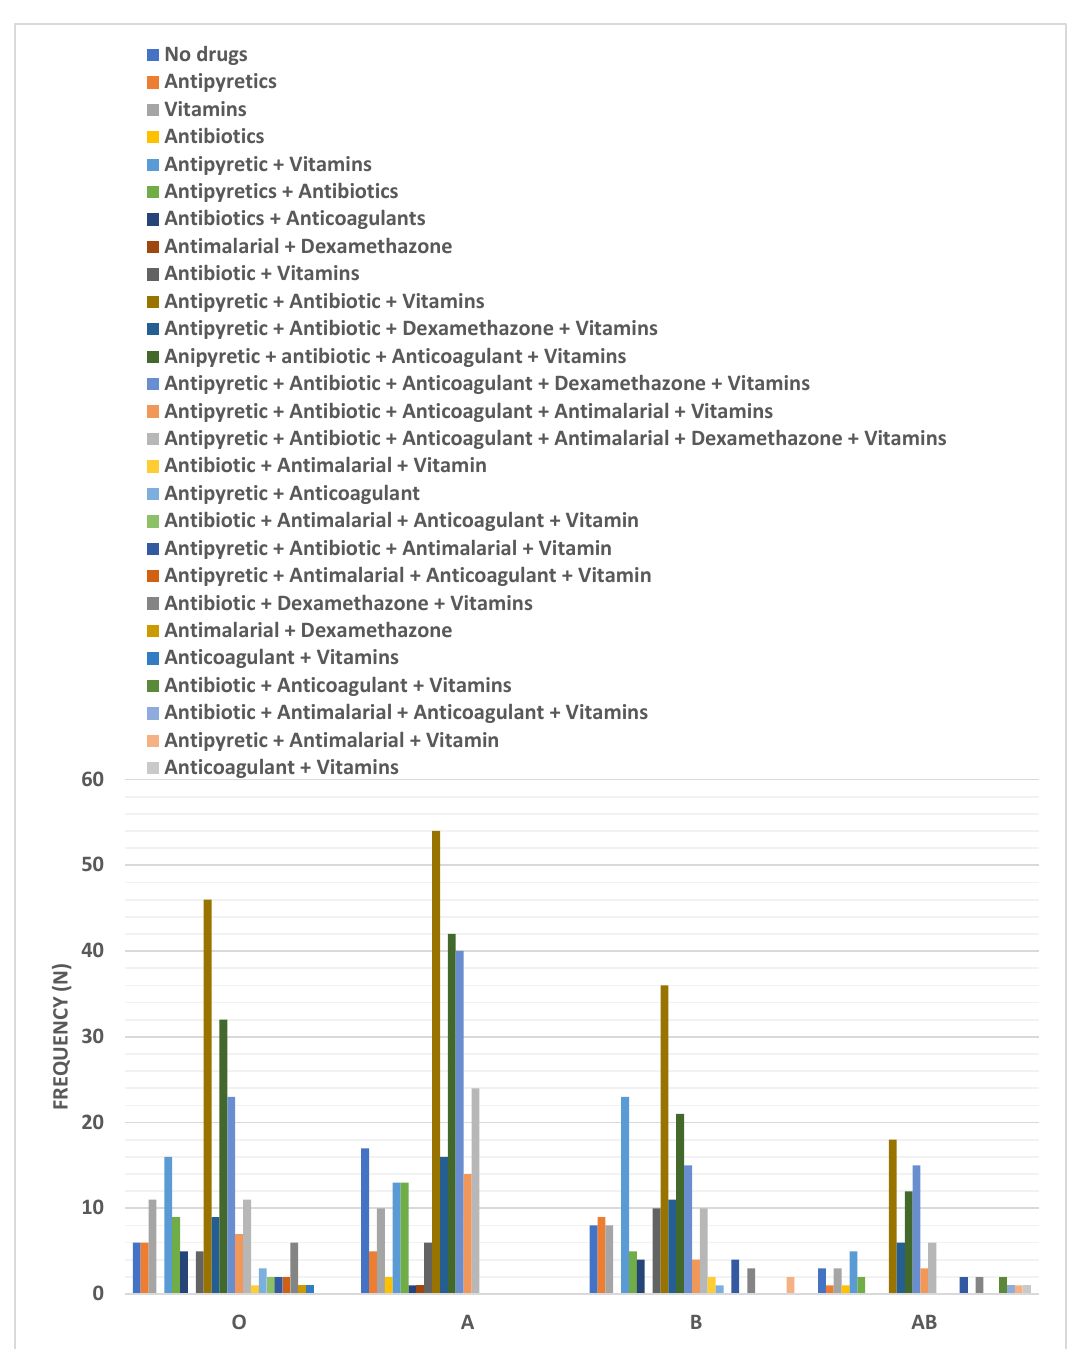
Figure 4. Distribution of different treatment regimens among the COVID-19 group according to the blood grouping. Data were presented as frequency (number).